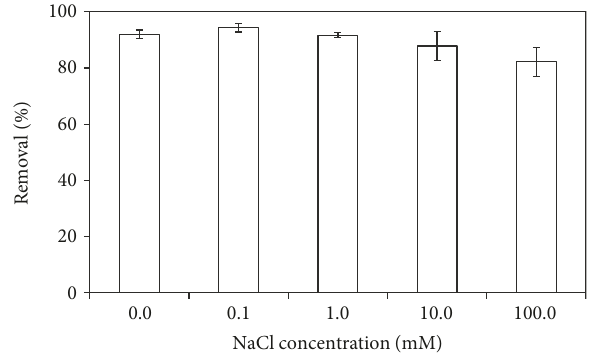
Figure 13: In fl uence of NaCl concentration on removal of Cd 2+ using surfactant-modi fi ed γ -Al time120min). Errorbars showstandard deviationsof three